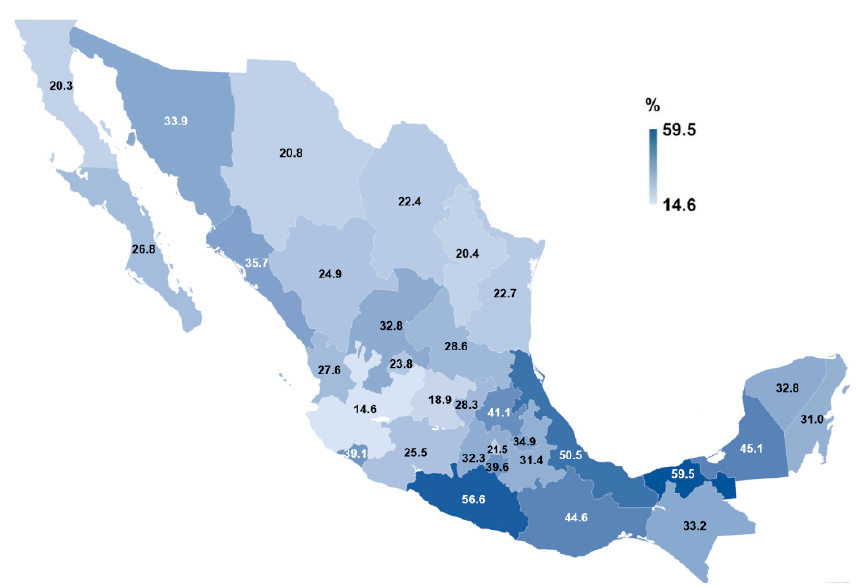
Figure 2. Prevalence of food insecurity in Mexican university students’ households in the 32 Mexican states according to the Mexican Scale of Food Security ( EMSA, for its Spanish acronym). Food insecurity categories include mild, moderate, and severe food insecurity. Table 1 shows sociodemographic students´ characteristics according to household FI categories. We observed significant differences in sociodemographic variables ( p < 0.05), except for student sex and having a scholarship (Table 1).